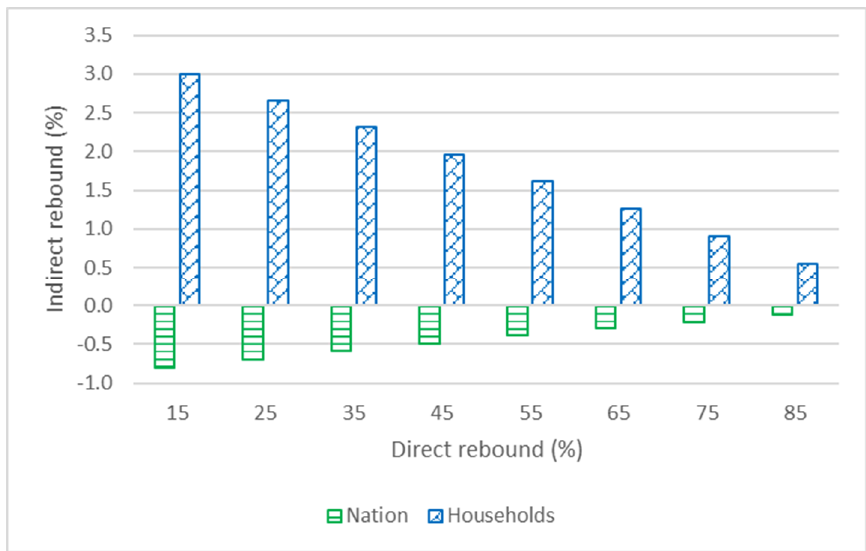
Figure 2. The indirect rebound e ff ect at the national level and at the households’ level in the Medium Scenario with various assumed direct rebound e ff ect of an e ffi ciency improvement of electricity used by households in China. The calculation is based on an input–output model using the 2017 data.